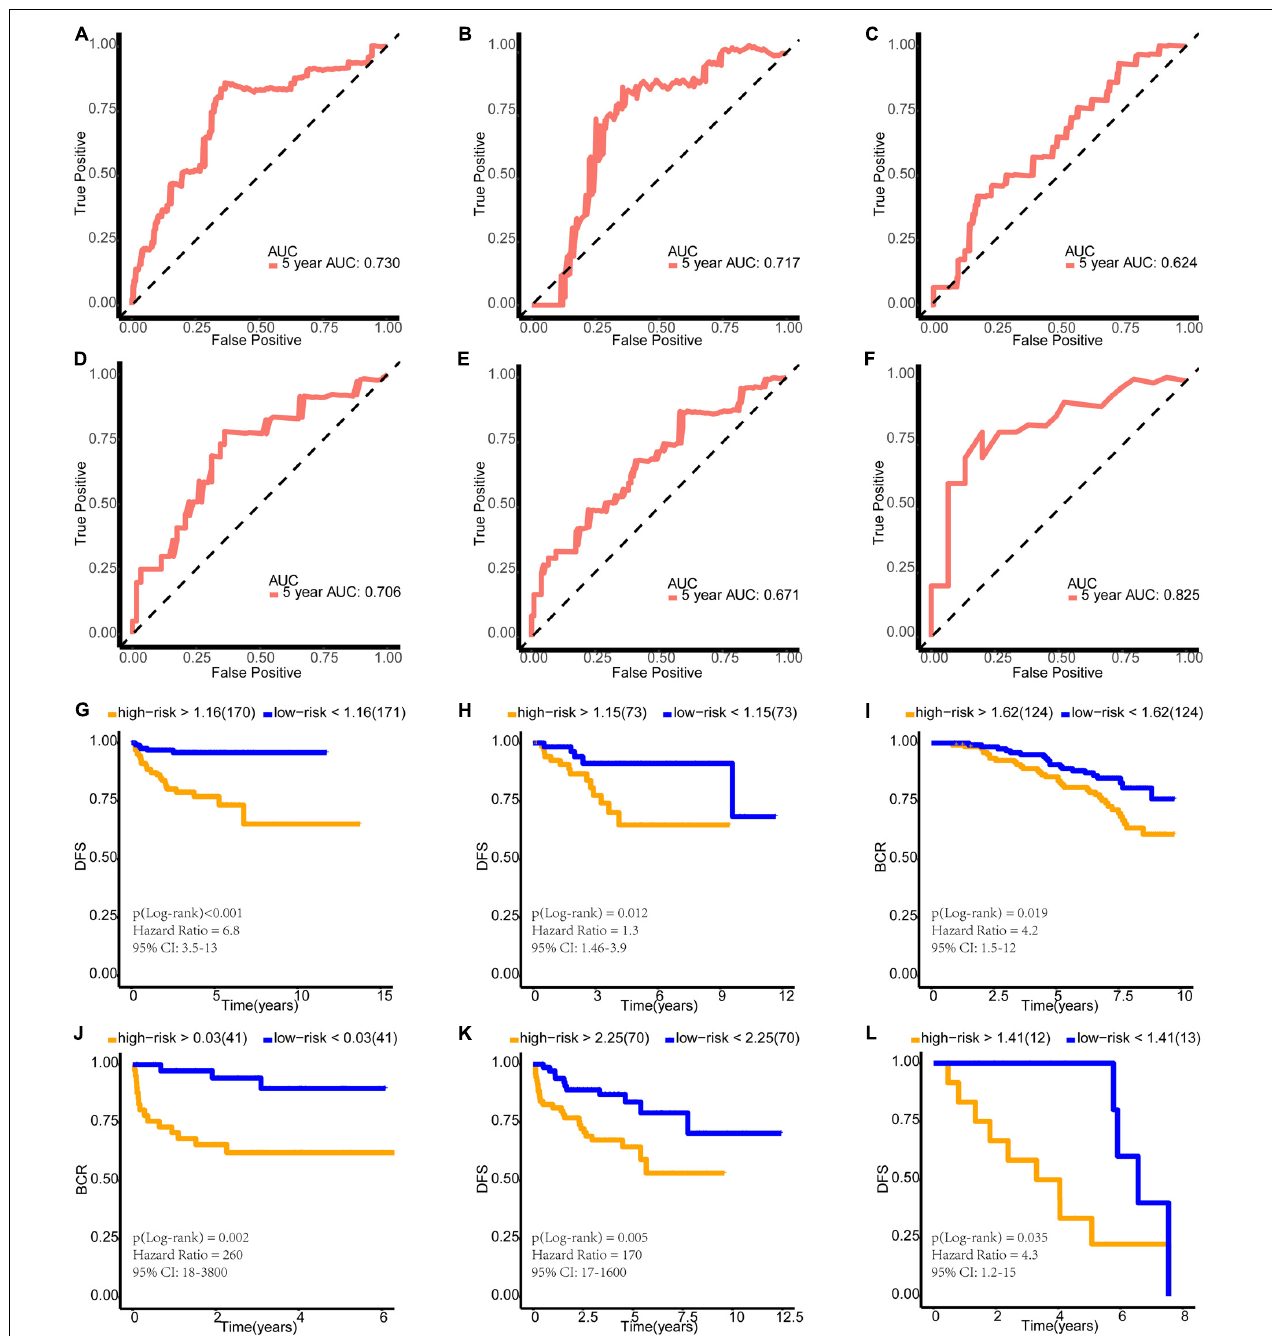
FIGURE 8 | Verification of the effectiveness of the model. (A–F) The ROC curve of 5-year follow-up time. (G–L) Kaplan–Meier curve for survival analysis. (A,G) The results in the training set. (B,H) The results in the internal validation set. (C,I ) The results in GSE116918. (D,J) The results in DKFZ2018. (E,K) The results in MSKCC2010. (F,L) The results in ICGC-PRAD-FR. AUC, area under curve; DFS, disease-free survival; BCR, biochemical recurrence-free